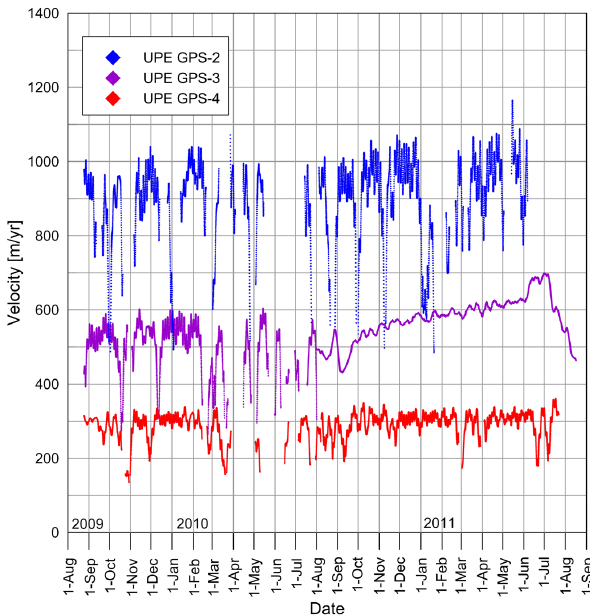
Figure 8. Upernavik Glacier 7-day averaged GPS velocities (see Fig. 1 and Table 1 for instrument position and operational period). The generally poor quality of the averaged velocities is due to data damage during logger extraction, causing a necessary relaxation of the averaging criteria used. The data are still useful for obtaining a general idea of the velocities, however.